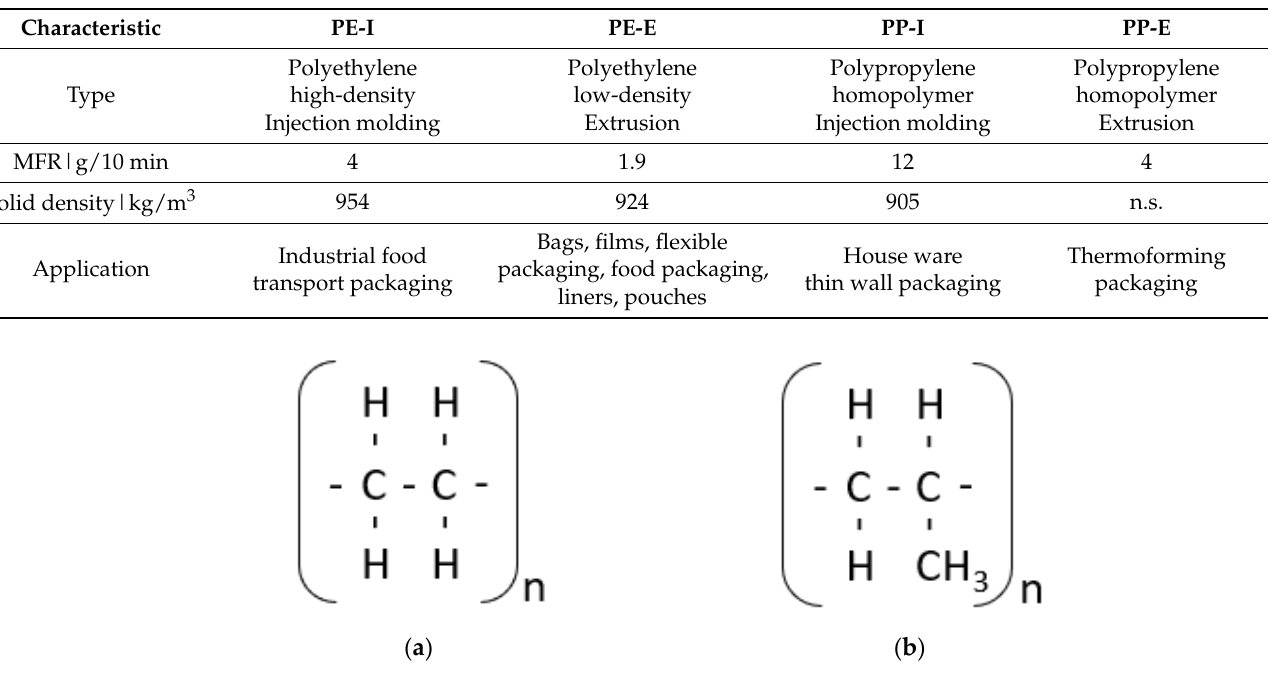
Table 1. Material designation including melt flow rates (MFR), solid densities and application fields.